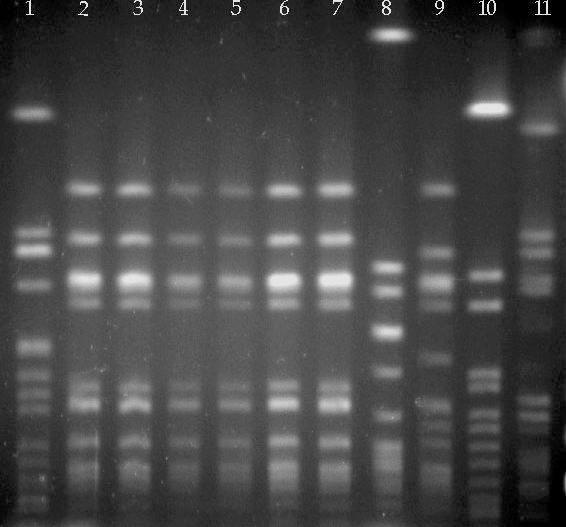
Molecular typing of MRSA isolates.Pulse-Field Gel Electrophoresis Patterns for MRSA strains isolated from four children vaccinated by vaccinator X (lanes 3–6 ), consecutive nasal swabs from vaccinator X (lanes 2, 7), a nasal swab from the son of vaccinator X (lane 8 ), strain HT2001-0751 (lane 9), hospital-acquired strain CV91 (lane 1) and strains ATCC 25923 (lane 10) and ATCC 33591 (lane 11).